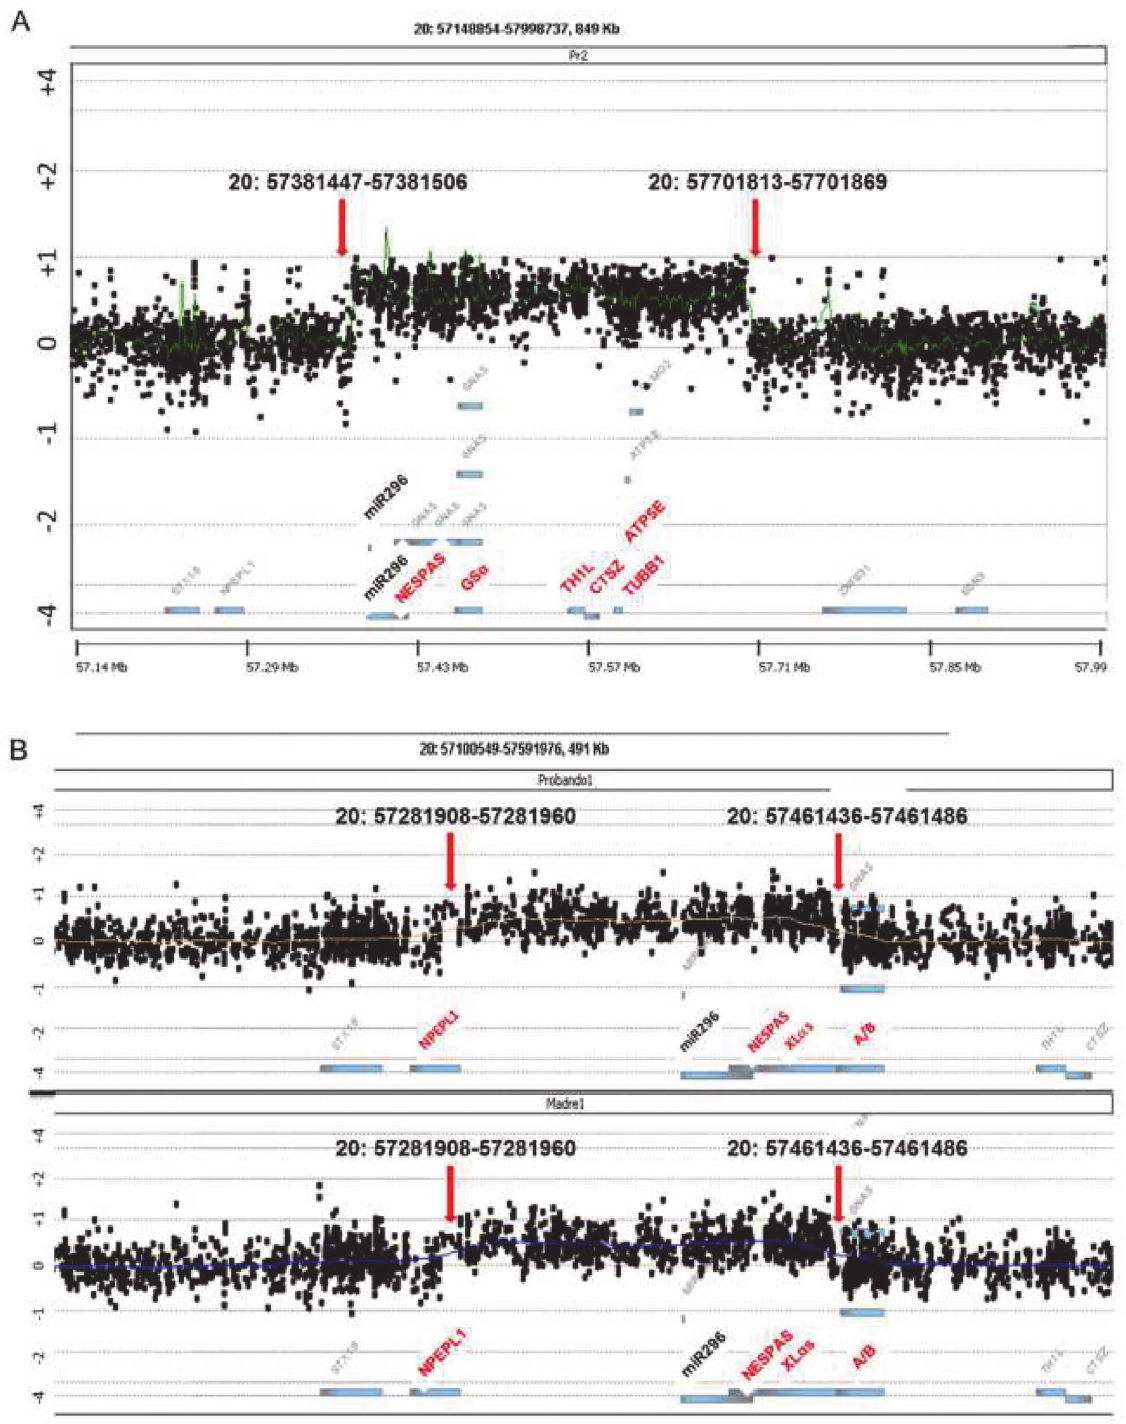
Fig 3. High density aCGH assay results for the 20q13 region of both families. In both cases, affected genes and regions mentioned in the text are highlighted in red on the X-axis. On the Y-axis, binary logarithm of the sample/control ratio. miR296 location is indicated in bold (corresponds to chr20:57392669 – 57392748). Red arrows indicate the location of the probes at each breakpoint. (A) Results for GS0131 index case. Won probes correspond to coordinates chr20:57381447 – 57701869. (B) Results of family GS0155 (upper panel, index case; lower panel, mother). Won probes correspond